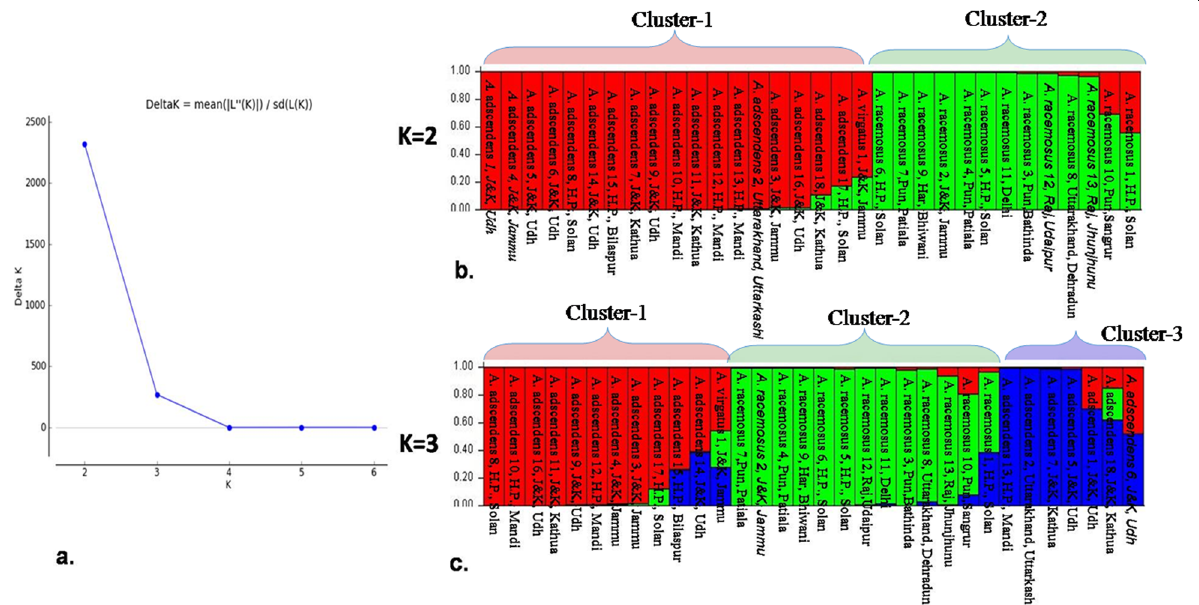
Fig. 1 Population genetic structure of Asparagus species. a Graph showing the best value of K at 2. b Bar plot of structure at K = 2 indicating less admixture between analyzed accessions. c Bar plot at K = 3 showing two clusters of A. adscendens and higher